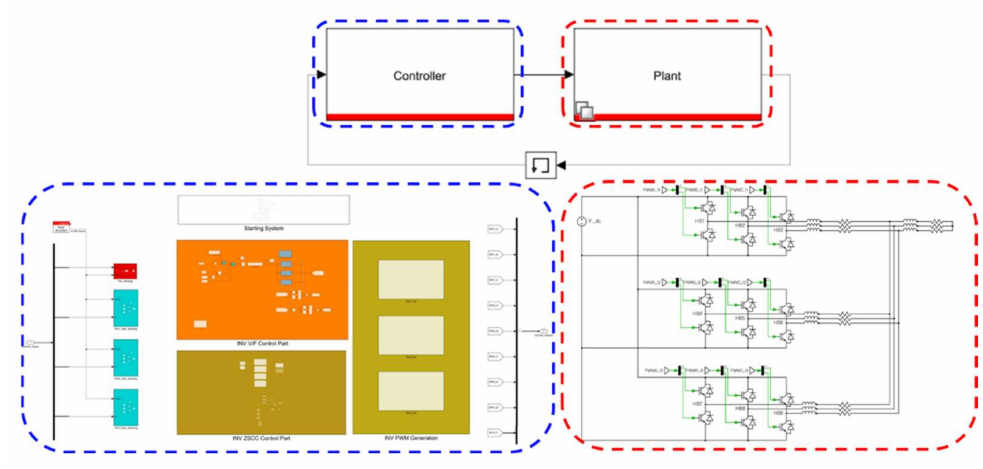
Figure 8. Simulation diagram. Table 1. Simulation